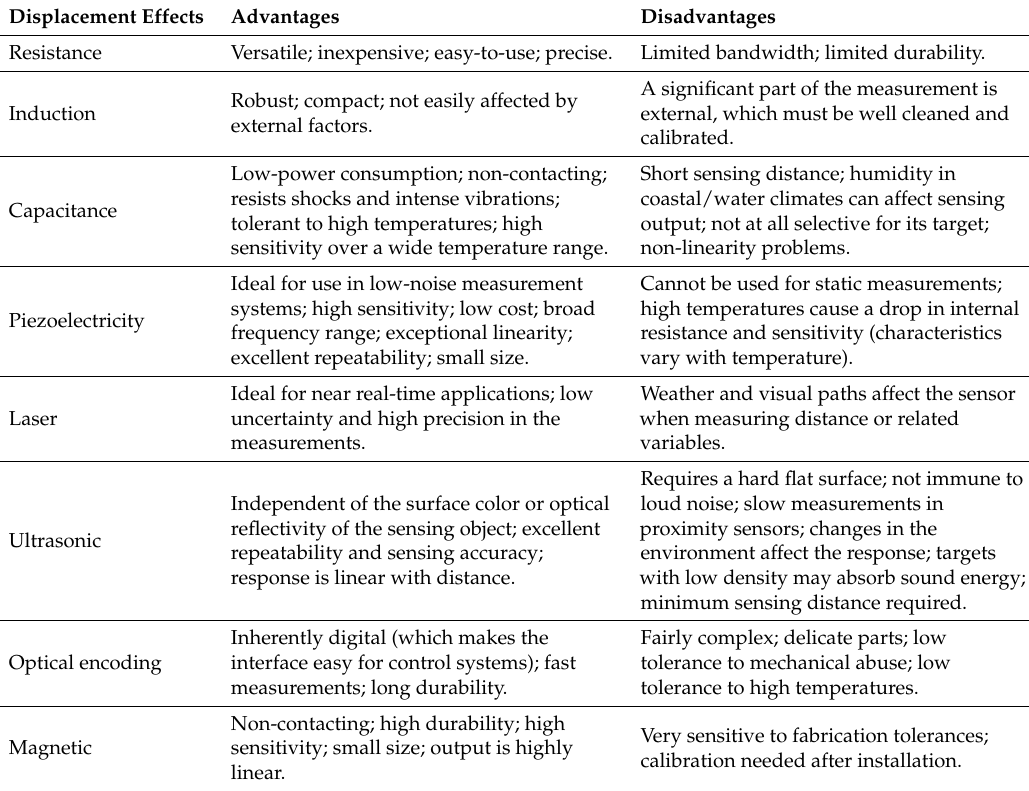
Table 1. Advantages and disadvantages of the various displacement effects